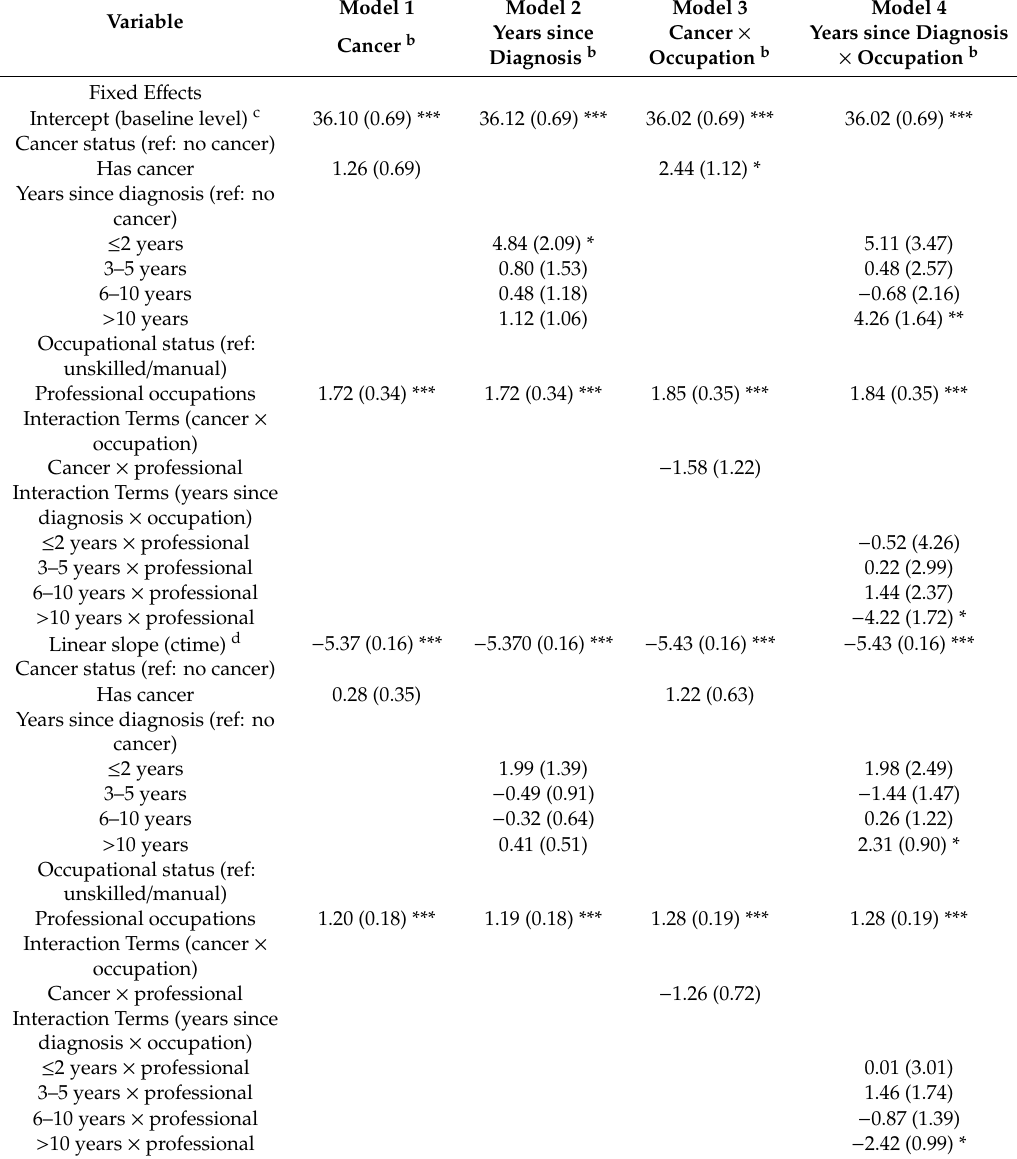
Table 3. Cancer and Weekly Hours Worked among Full-time Employed Women a